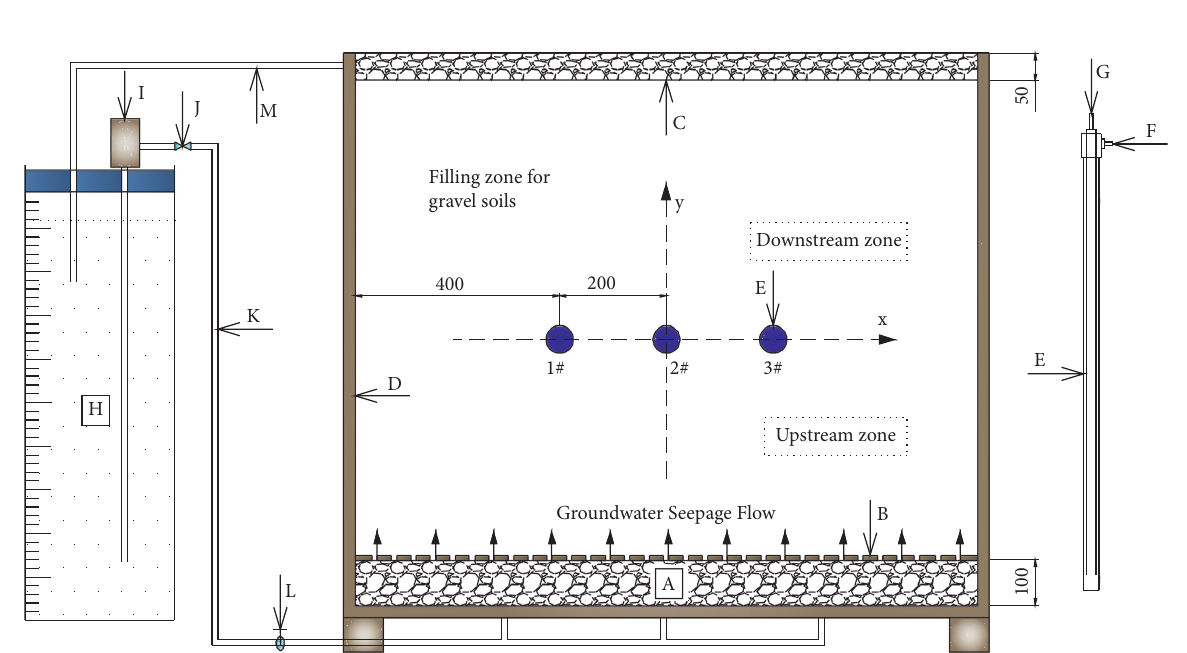
Figure 2: Schematic of the physical modelling experiment apparatus (unit: mm): (A) water feeding zone filled with pebbles, (B) perforated aluminium plate, (C) water draining zone filled with pebbles, (D) wall of physical modelling box, (E) freezing pipes, (F) brine outlet, (G) brine inlet, (H) thermostatic water tank, (I) power water pump, (J) water flow gauge, (K) water feeding tube, (L) water flow valve, and (M) water draining tube.